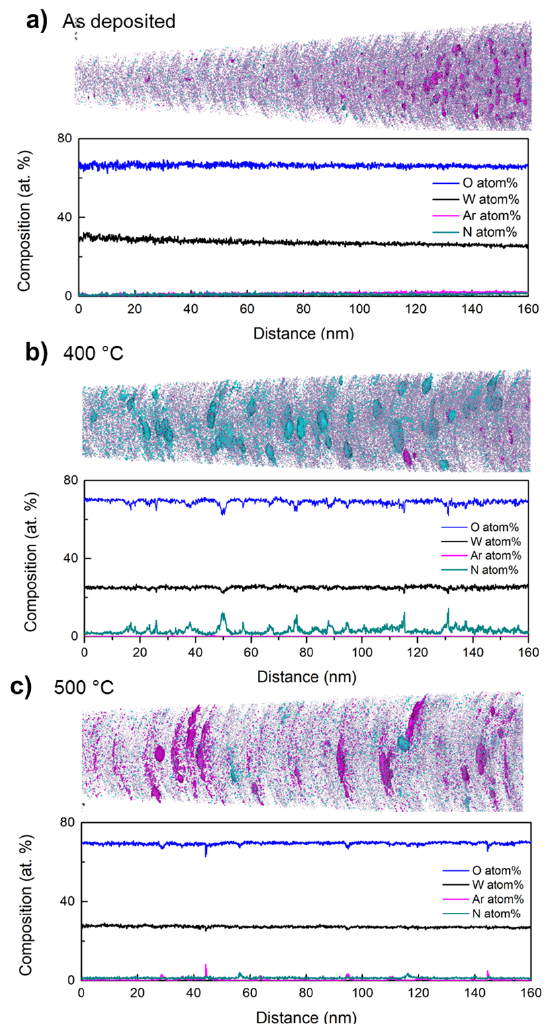
Figure 4. Atom probe tomographs (up) with corresponding concentration profiles (down) for ( a ) as deposited and annealed at ( b ) 400 °C and ( c ) 500 °C WO 3 thin films deposited onto Al 2 O 3 .